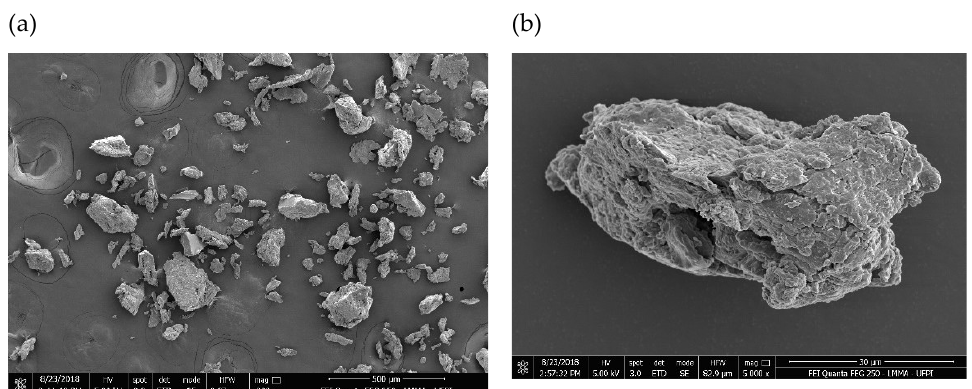
Figure 3. SEM image of EPSwk at ( a ) 200× and ( b ) 5000×.